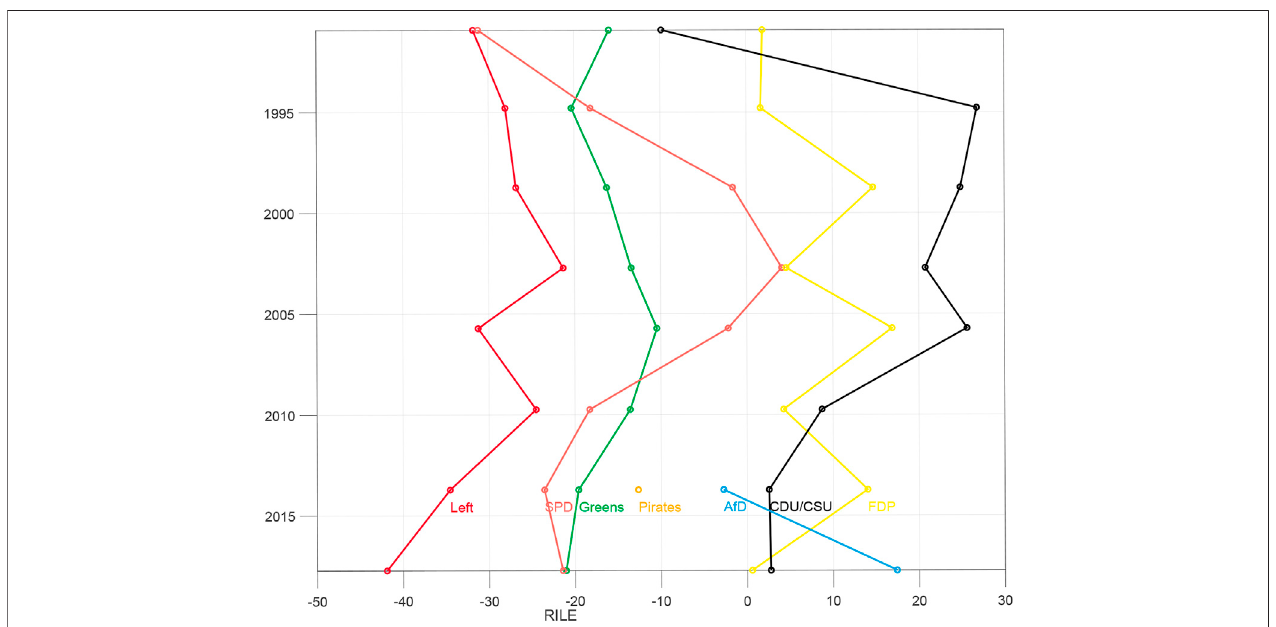
FIGURE 1 | RILE index of the German parties between 1990 and 2017.